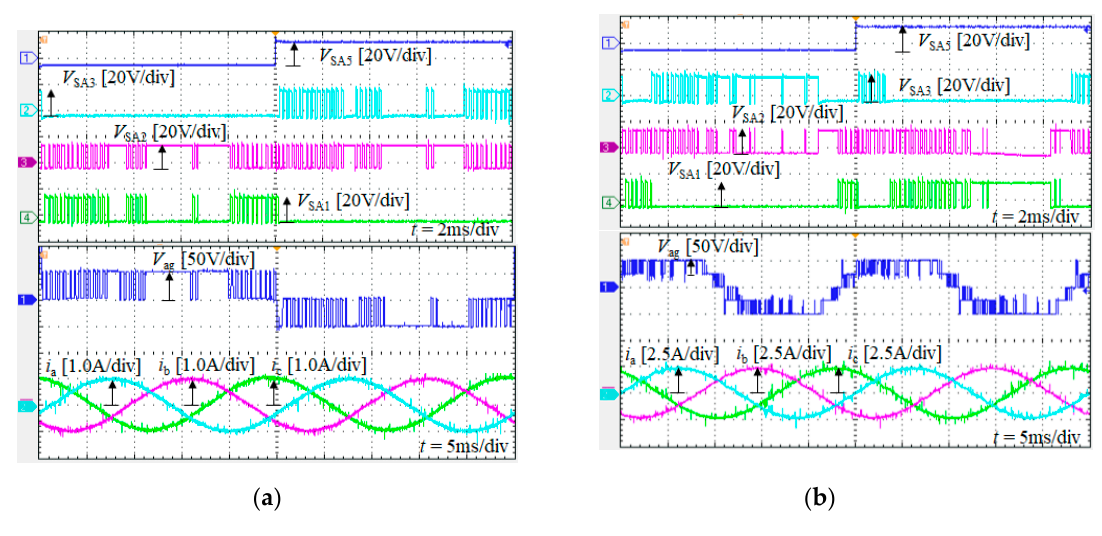
Figure 9. Experimental results at ( a ) m = 0.4 and ( b ) m = 0.9.